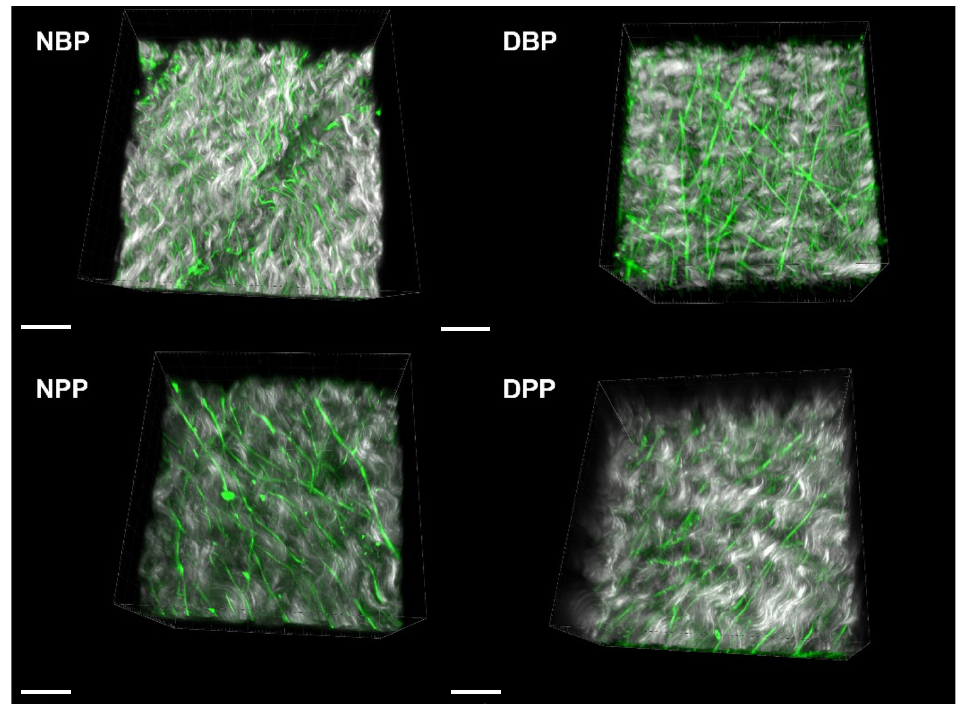
Figure 5. Three-dimensional representations of collagen (grey) and elastin (green) for the serosa side of NBPs, DBPs, NPPs, and DPPs. Scale bar = 20 micron.